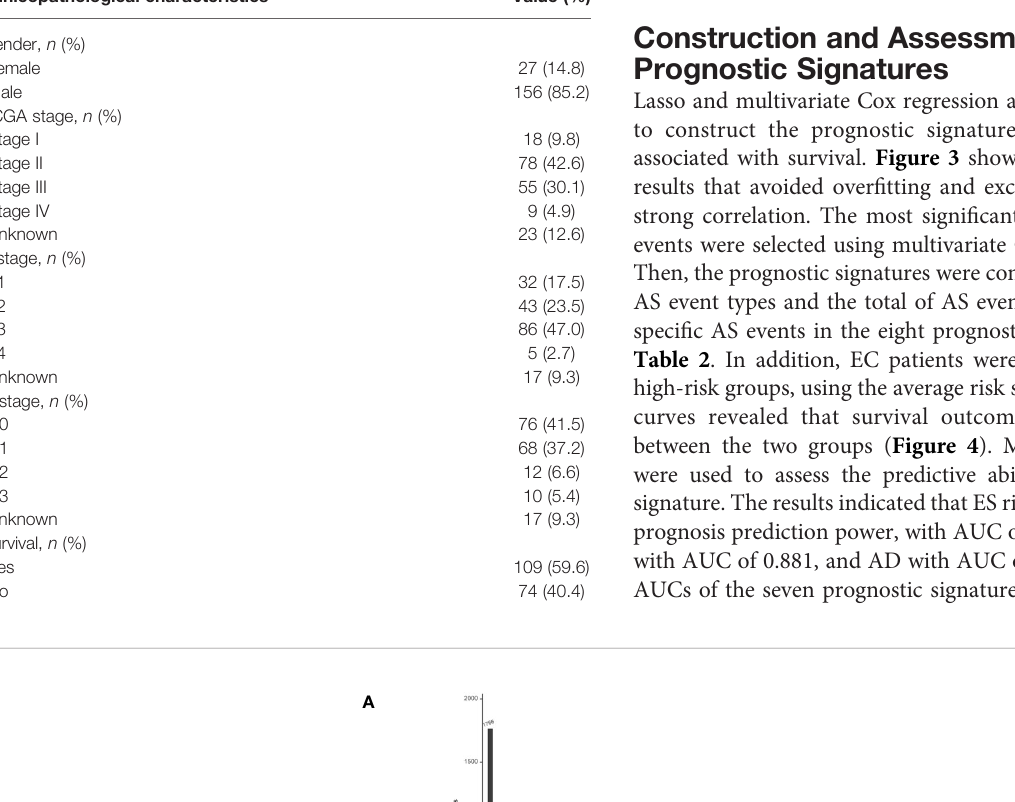
TABLE 1 | Clinicopathological characteristics of 183 patients with esophageal carcinoma from the TCGA database. Clinicopathological